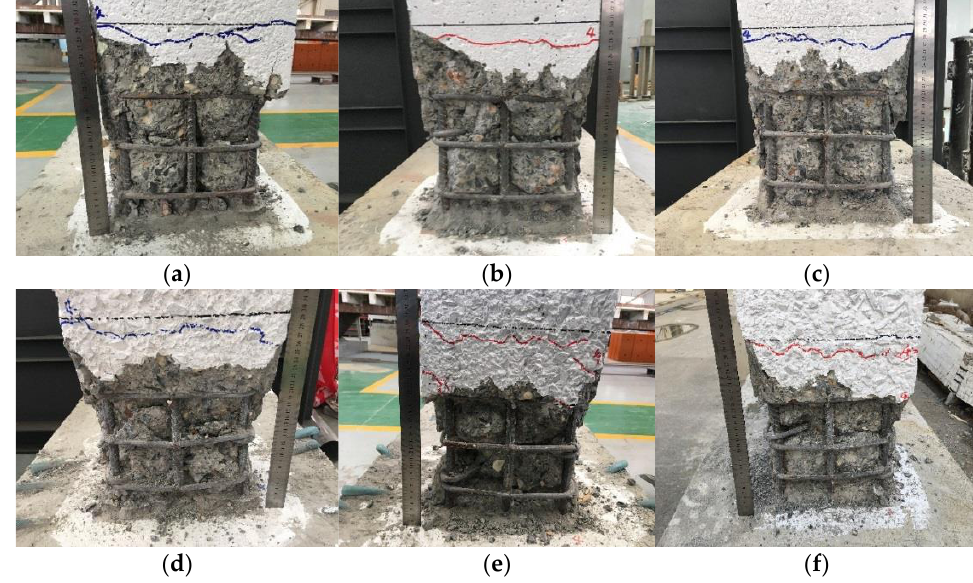
Figure 19. Concrete spalling height of the specimen. ( a ) JP-F0. ( b ) JP-F1. ( c ) JP-F2. ( d ) JP-F3. ( e ) JP-F4. ( f ) JP-F5.